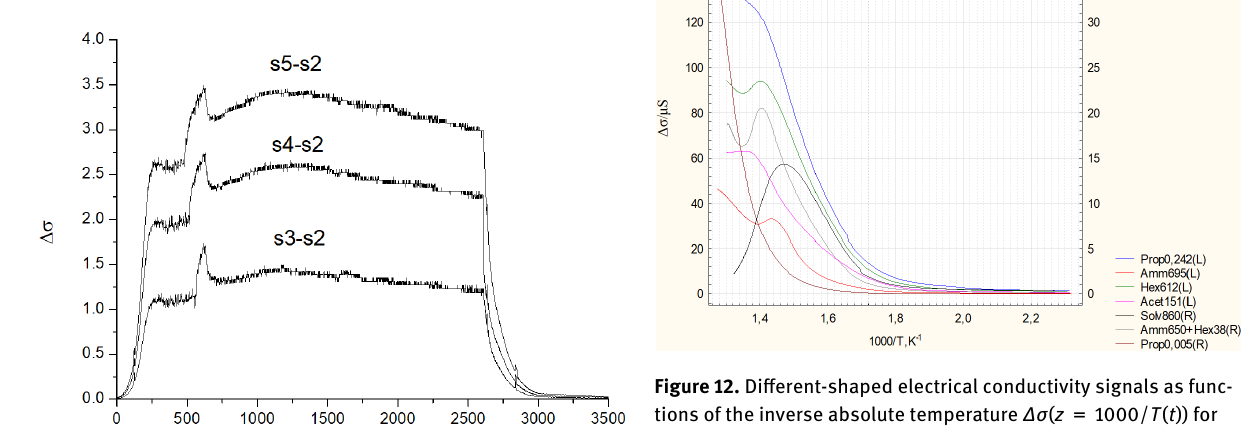
Figure 9. Time difference signal of the SmS-based sensor conduc- tivity change for three different concentrations of methane vapor in atmospheric air (heating and cooling).